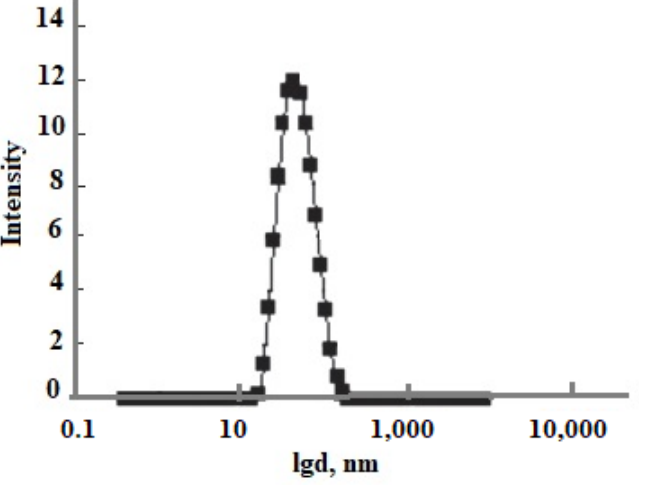
Figure 13. The particle size distribution based on DLS results. d is the particle diameter, nm. Well 054 at the Mutnovsky field.